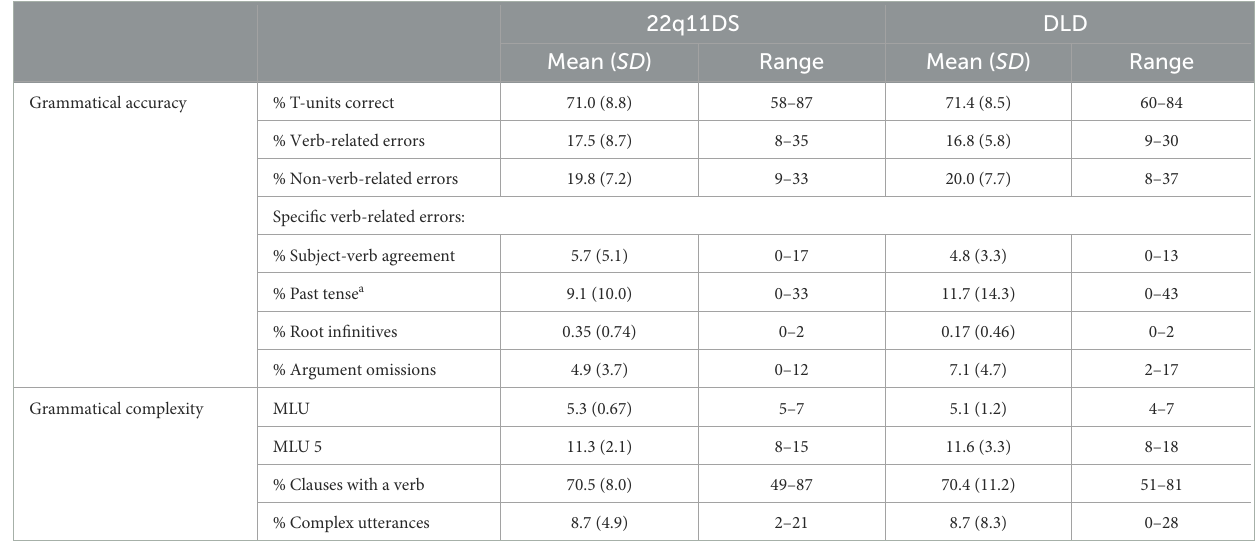
TABLE 6 Outcomes of the two groups of school-aged children on the spontaneous language